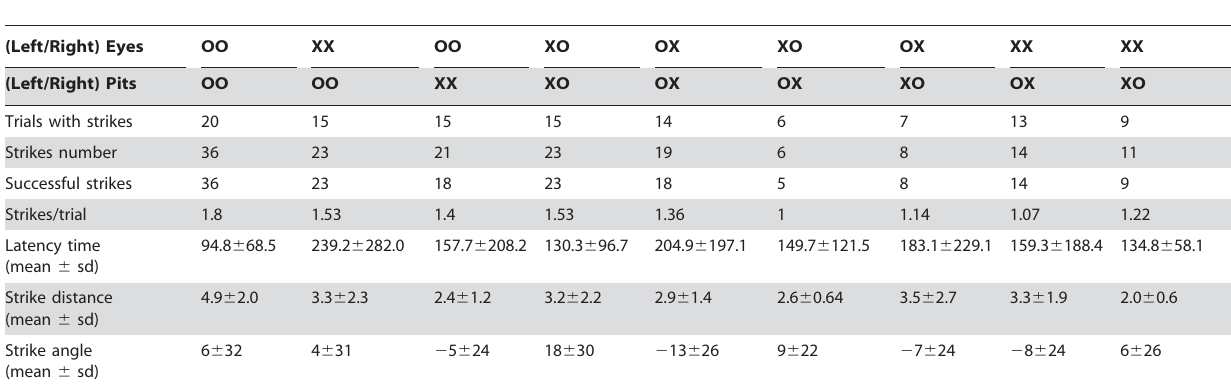
Table 1. Summary of parameters of prey attack for snakes in different occlusive conditions.